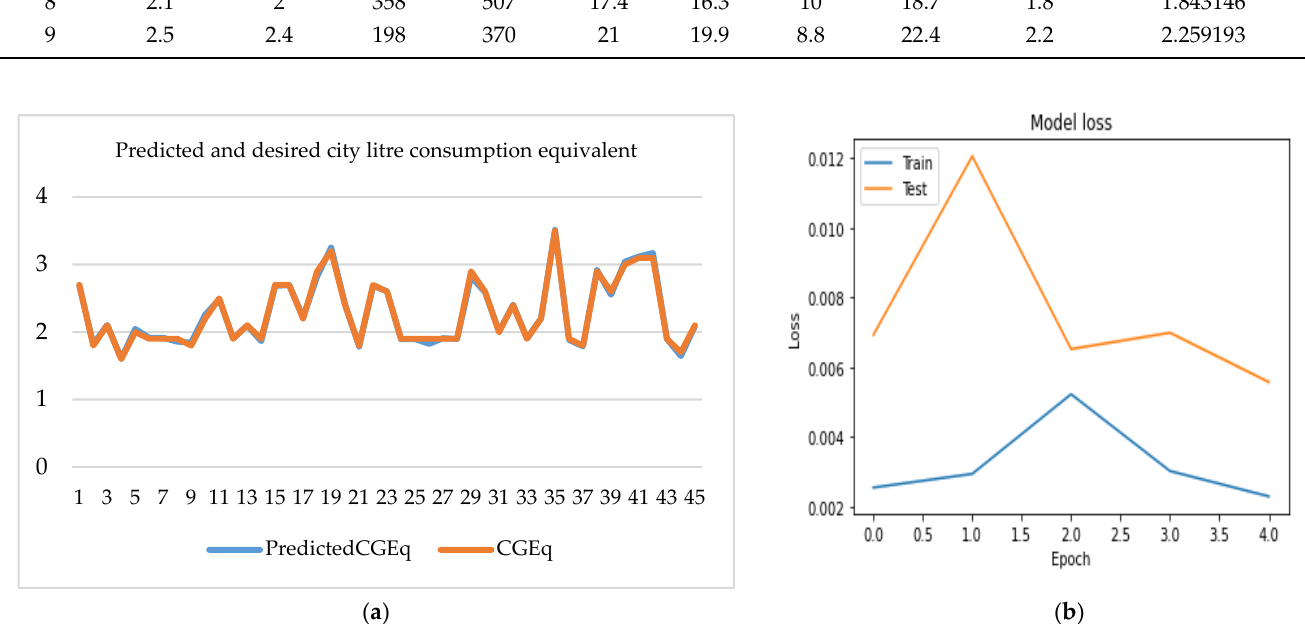
Figure 10. City gasoline litre consumption equivalent analysis. ( a ) Behaviour of city gasoline litre consumption equivalent; ( b ) Model loss with increase in epoch. Table 6. Predicted and desired city gasoline litre consumption equivalent.